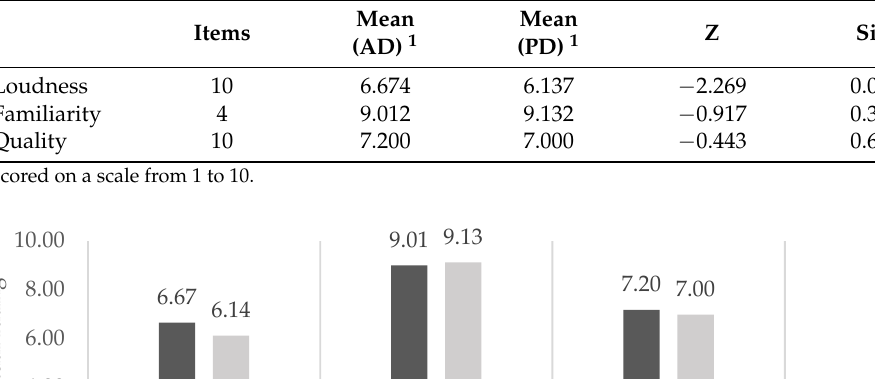
Table 3. Perceptual rating of audio samples with PD and AD settings.